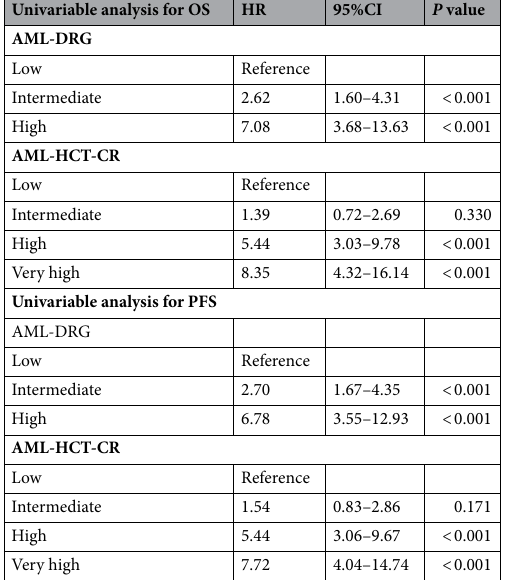
Table 3. Univariable analysis evaluating the impact of the HCT-CR model on OS and PFS. HR hazard ratio, CI confidence interval, OS overall survival, PFS progression-free survival.